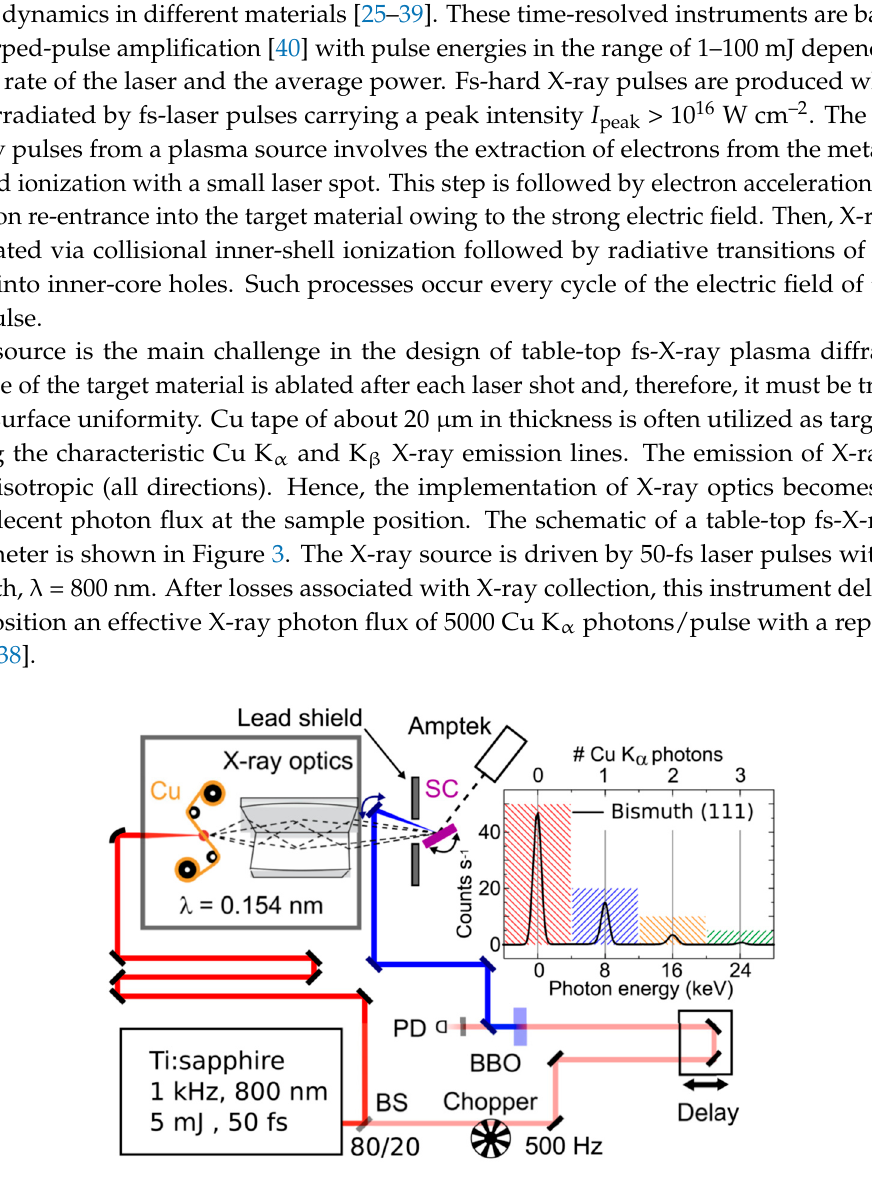
Figure 3. Layout of the table-top fs-X-ray plasma diffractometer at the Max Born Institute. In this example, a (1 1 1)-oriented single crystalline (SC) Bi sample is photoexcited by 400-nm laser pulses generated by frequency doubling in a β -barium borate (BBO) crystal. The pump arm is mechanically chopped. A photodiode (PD) is used to determine the state of the sample (i.e., excited or unexcited) on shot to shot basis. Diffracted X-ray photons are measured by an energy-resolving CdTe diode (Amptek). The inset shows a spectrum with a very low X-ray flux on the detector. Figure adapted from Reference [38] with permission from the